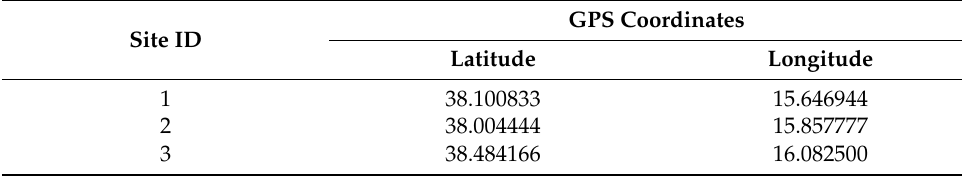
Table 1. The IDs and GPS coordinates of the sampling